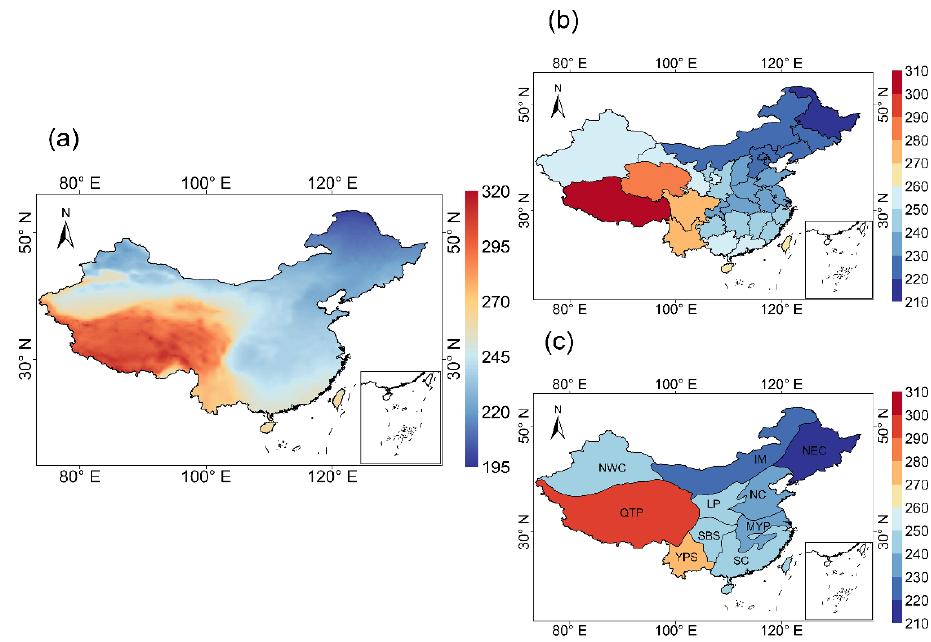
Figure 3. Annual average spatial distribution of POAI (Wm − 2 ) under clear-sky conditions in China from 2010 to 2020. ( a ) is the total annual average spatial distribution of clear-sky POAI. ( b ) the same as ( a ) but for each province. ( c ) the same as ( a ) but for each geographical region.